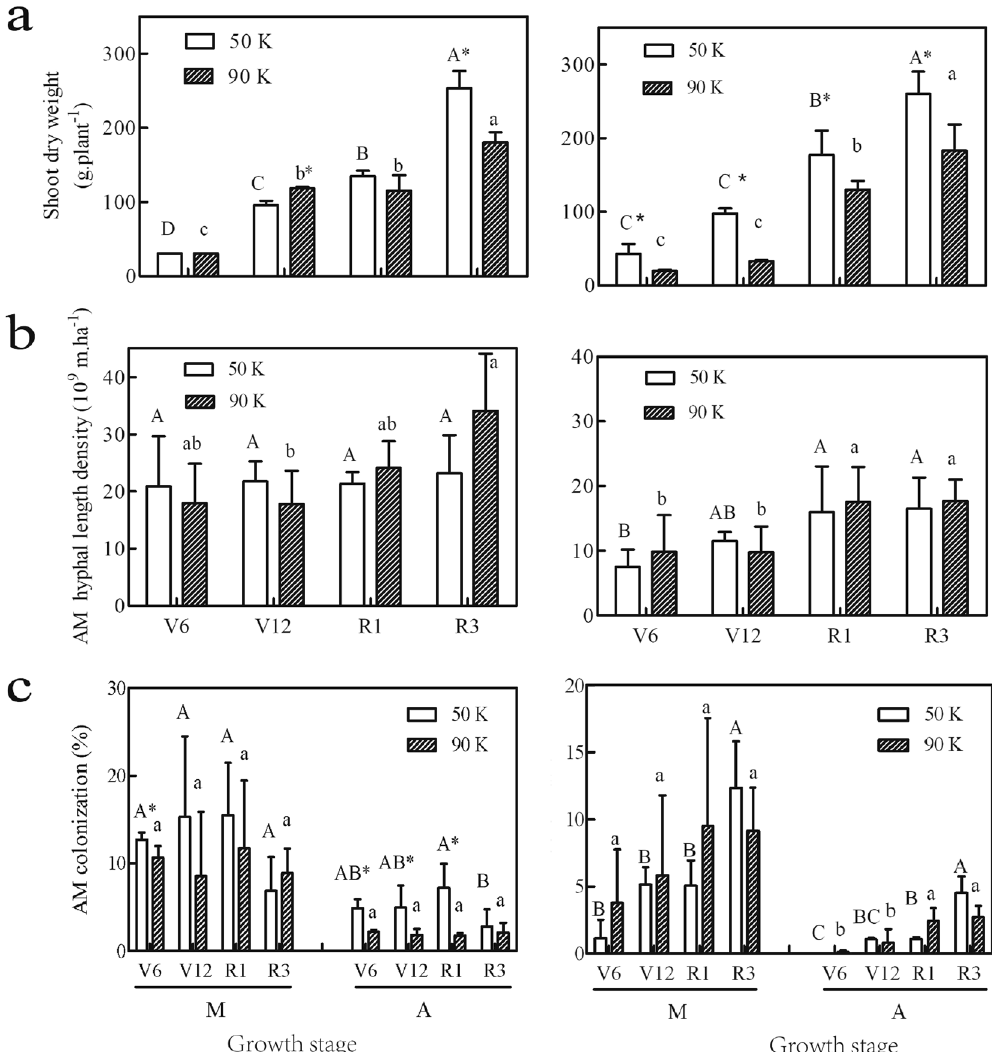
Figure 1. Maize shoot dry weight ( a ), hyphal length density ( b ), and AM fungal colonization ( c ) at different growth stages and planting densities in 2013 (left column) and 2014 (right column). The intensity of mycorrhizal colonization (M) and the arbuscular abundance (A) was measured in the root system. DW, dry weight. Error bars represent SD values of the means (n = 3). Different uppercase letters indicate significant differences ( P ≤ 0.05) among growth stages under low planting density; different lowercase letters indicate significant differences ( P ≤ 0.05) among growth stages under high planting density; asterisks indicate significant differences ( P ≤ 0.05) between different planting densities.